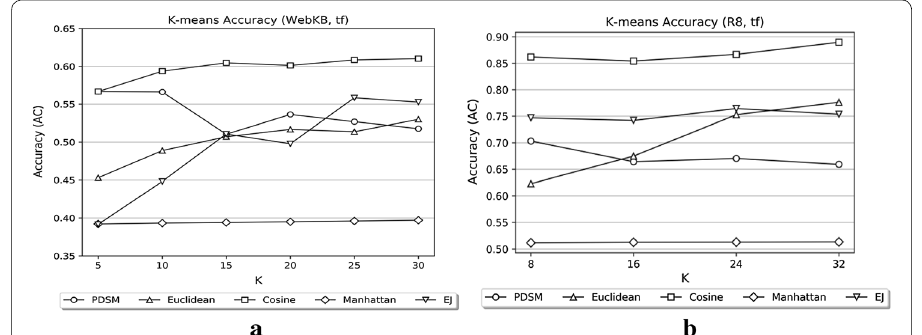
Fig. 4 AC values by K -means with different measures in tf: a WebKB (the combination of test and training sets). b R8 (the combination of test and training sets)